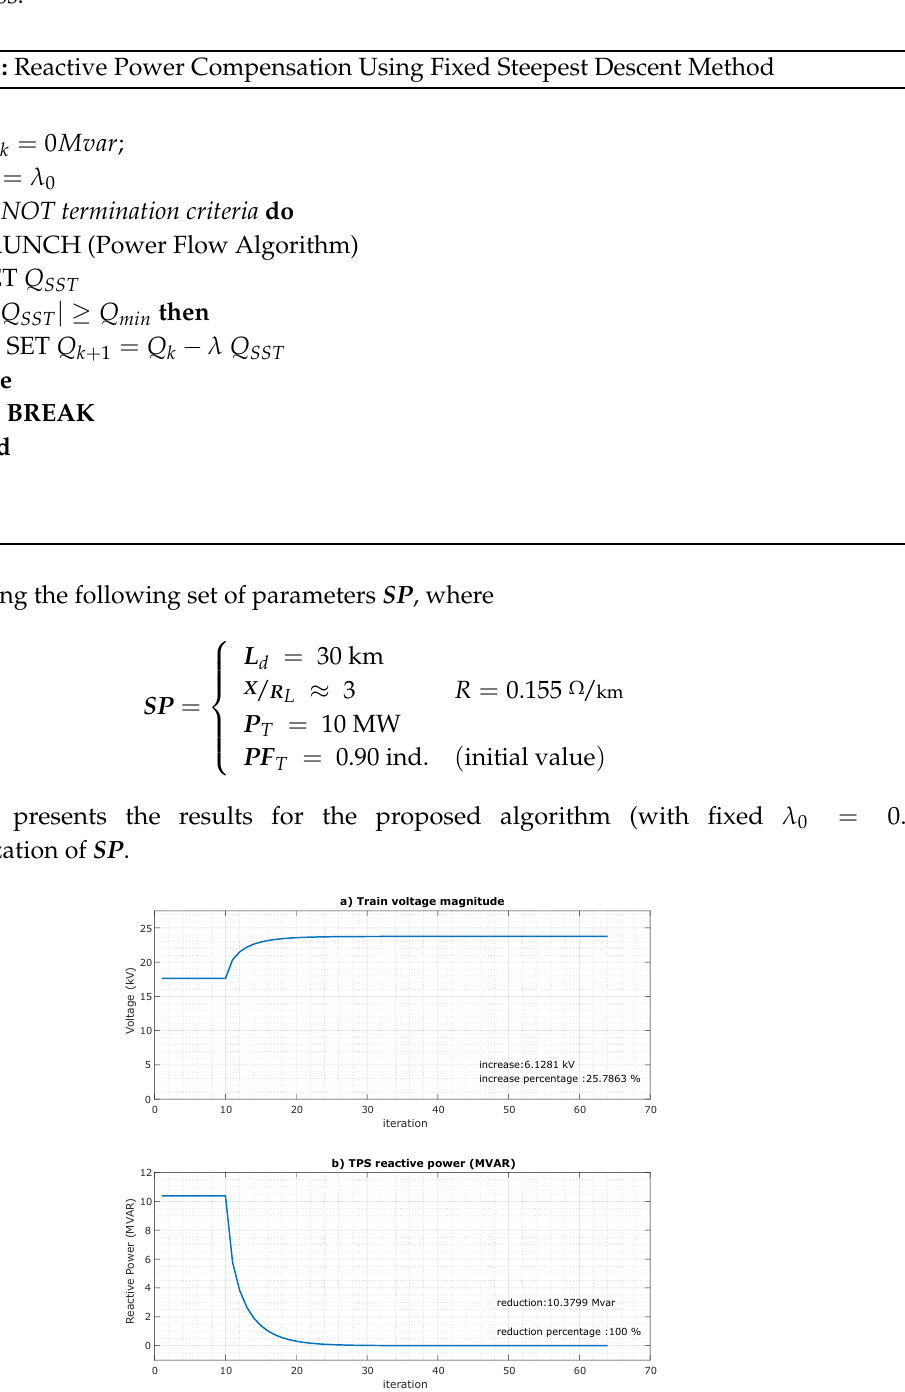
Figure 7. Illustration of algorithm evolution for reactive power compensation: ( a ) evolution of train voltage; ( b ) evolution of SST reactive power. Note, for illustration purposes, that the reactive compensation procedure is only enabled at iteration it =